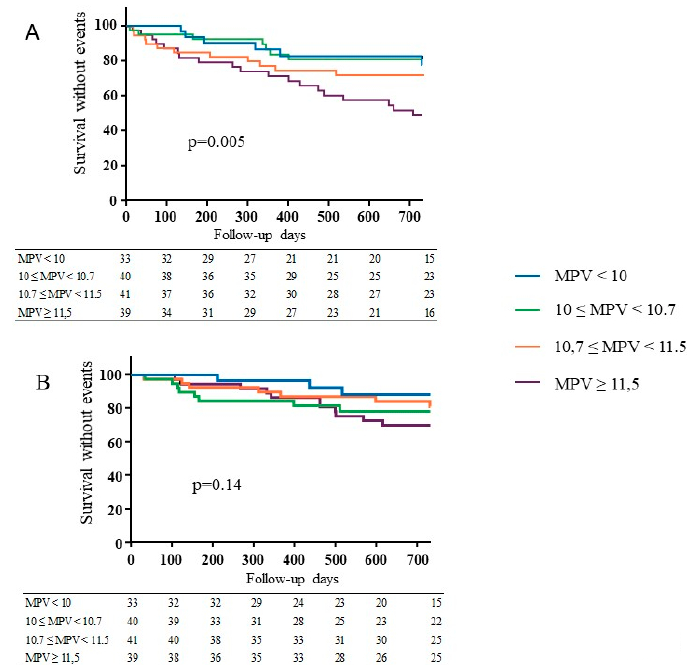
Figure 3. ( A ) Kaplan–Meier plots of vascular access stenosis: 43 events occurred during the follow up with group 1: 18% n = 6/33 patients; group 2: 17% n = 7/40 patients; group 3: 27% n = 11/41 patients; group 4: 49% n = 19/39 patients. ( B ) Kaplan–Meier plots of vascular access thrombosis: 29 events group 4: 49% n = 19 / 39 patients. ( B ) Kaplan–Meier plots of vascular access thrombosis: 29 events occurred during the follow-up with group 1: 9% n = 3/29 patients; group 2: 20% n = 8/29 patients; occurred during the follow-up with group 1: 9% n = 3 / 29 patients; group 2: 20% n = 8 / 29 patients; group 3: 17% n = 7/29 patients; and group 4: 28% n = 11/29 patients. group 3: 17% n = 7 / 29 patients; and group 4: 28% n = 11 / 29